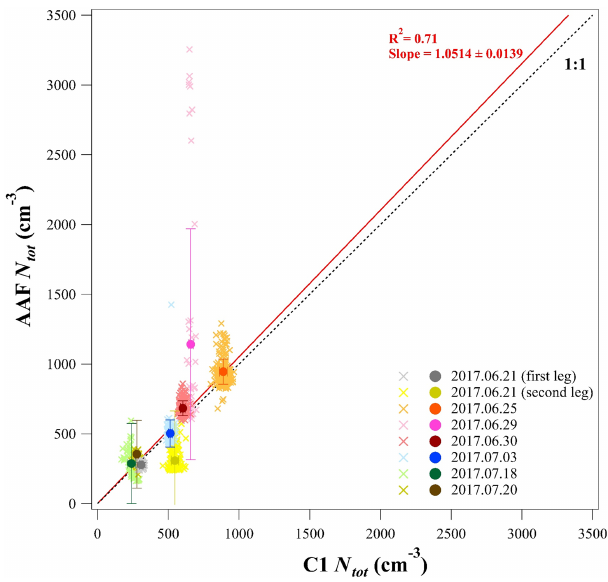
Figure 12. Scatter plot of ENA-AM masked C1 N tot and AAF N tot collected within 10km from C1 and at altitudes ≤